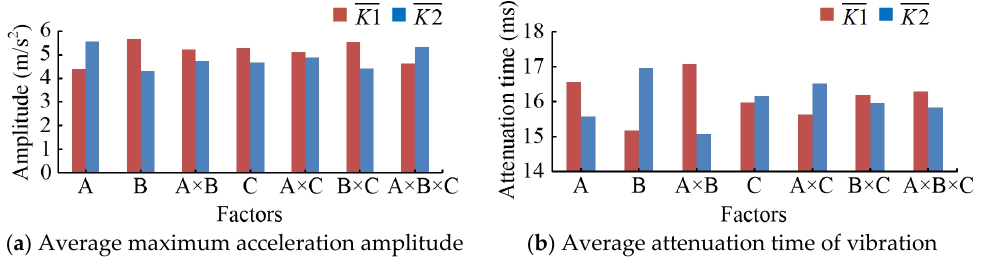
Figure 16. Range analysis results. Table 6. Analysis of variance